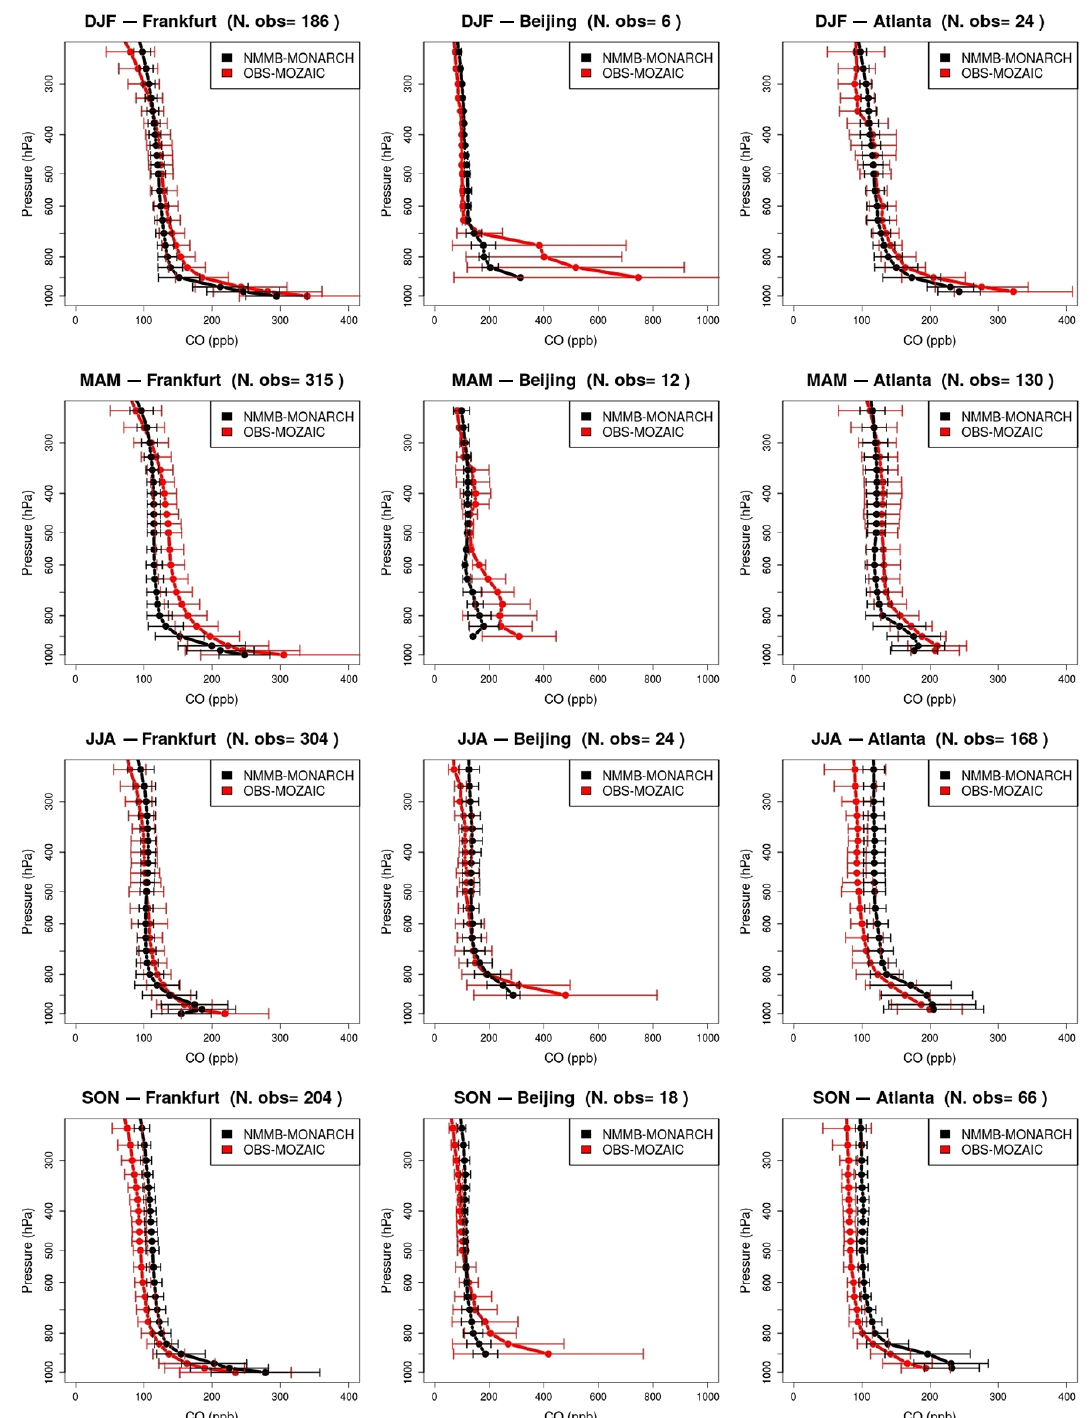
Figure 5. CO vertical profile seasonal averages over Frankfurt, Beijing and Atlanta (from left to right) for the year 2004 from MOZAIC. Observations depicted with a solid red line and the model with a solid black line. Horizontal lines show the standard deviations. The number of flights is provided on the top of each